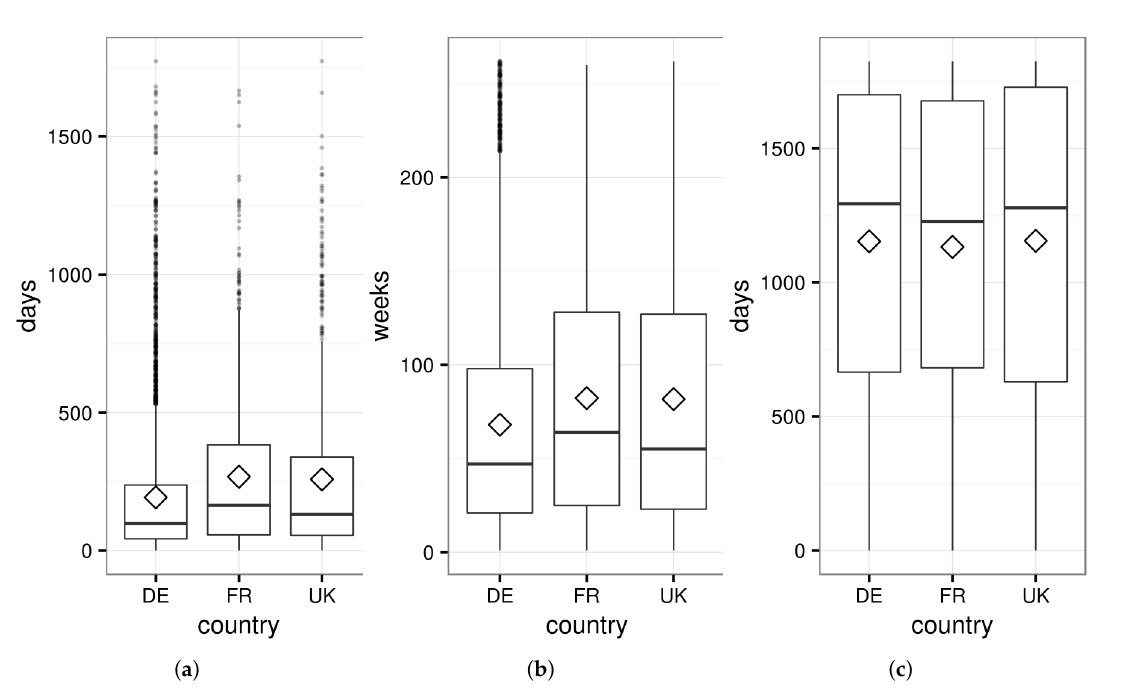
Figure 3. Distributions of practice indicators. ( a ) Days; ( b ) weeks; ( c ) range.